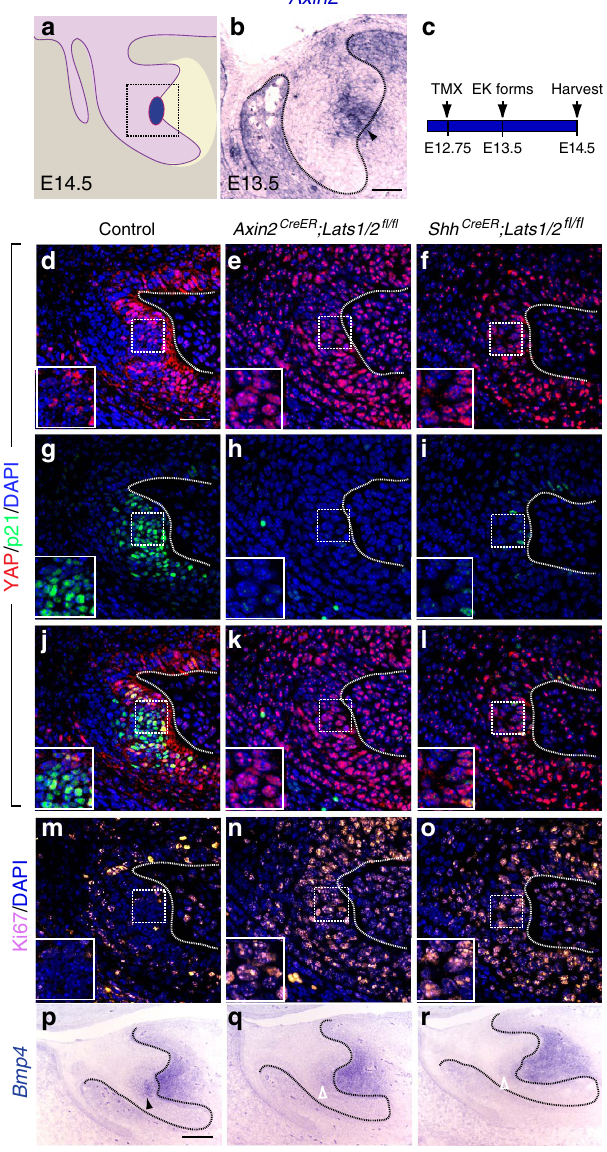
Figure 3 | Proper YAP localization is essential for the formation of EK during tooth development. ( a ) Schematic diagram of an E14.5 incisor tooth germ. Square box represents areas imaged in d – o . ( b ) In situ hybridization of Axin2 at E13.5 tooth germ (arrowhead indicates the expression of Axin2 in the EK). ( c ) Time course for treatment of Axin2 CreER ;Lats1/2 fl/fl and Shh CreER ;Lats1/2 fl/fl embryos with tamoxifen to delete Lats1 and Lats2 in the EK. ( d , g , j , m ) In the EK, YAP is excluded from the nucleus with increased p21 and decreased Ki67 expression at E14.5. ( e , f ) Double deletion of Lats1 and Lats2 with EK-specific Axin2 CreER and Shh CreER induces the nuclear localization of YAP. ( h , i ) Double deletion of Lats1 and Lats2 with EK-specific Axin2 CreER and Shh CreER decreases p21 expression. ( k , l ) Overlay images of YAP and p21 staining. ( n , o ) Double deletion of Lats1 and Lats2 in the EK induces ectopic cell proliferation, as shown by Ki67 staining. ( p ) In situ hybridization of the EK marker Bmp4 at E14.5 (black arrowhead). ( q , r ) Double deletion of Lats1 and Lats2 inhibits Bmp4 expression (open white arrowheads). Dotted lines outline the tooth germ epithelium in b – r